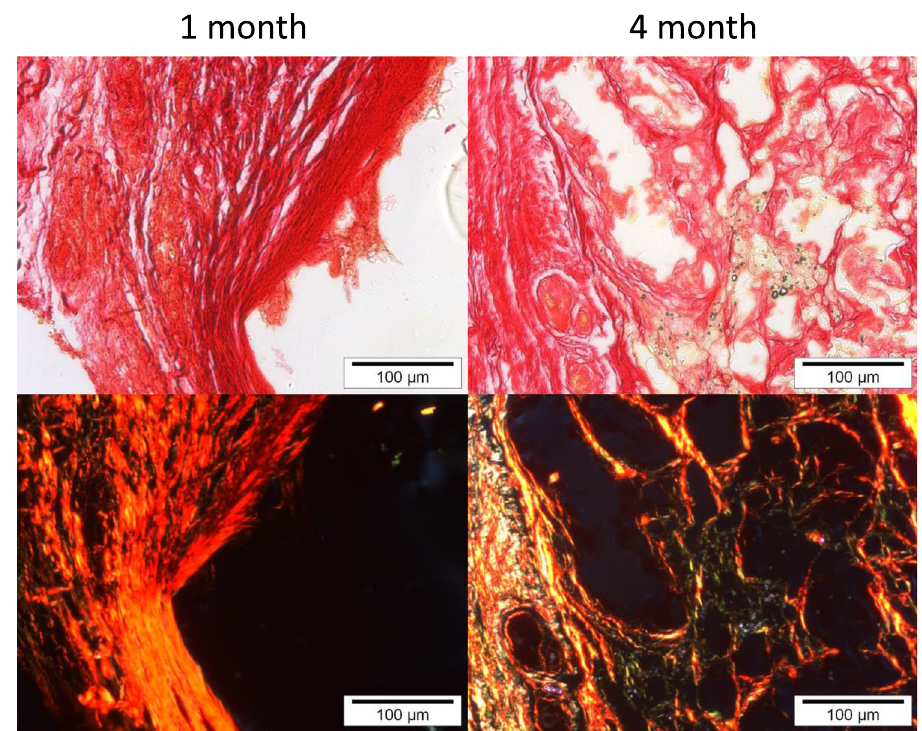
Fig. 6 Picrosirius Red staining of 80 cis :100 succinate elastomers after 1 month and 4 months of subcutaneous incubation. Collagen deposition and maturation occurred throughout the polymer space with different orientations representing both mature and developing collagen through the center of the polymer area. Scale bars are 100 μ m. Shown micrographs are representative of histology specimens ( n = 4) from each of six independent implants ( n = 6) for each